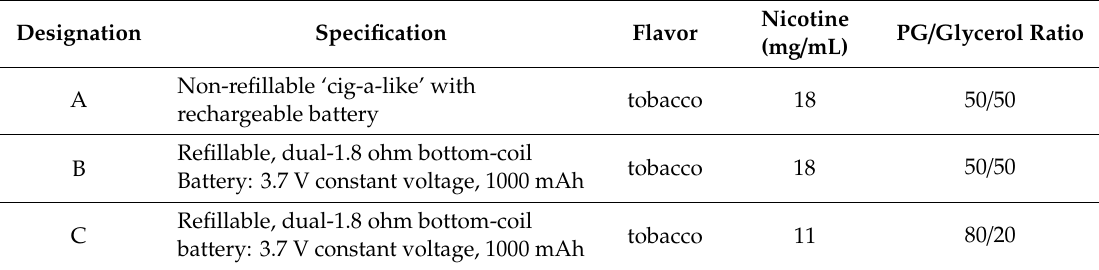
Table 1. E-cigarette / e-liquid